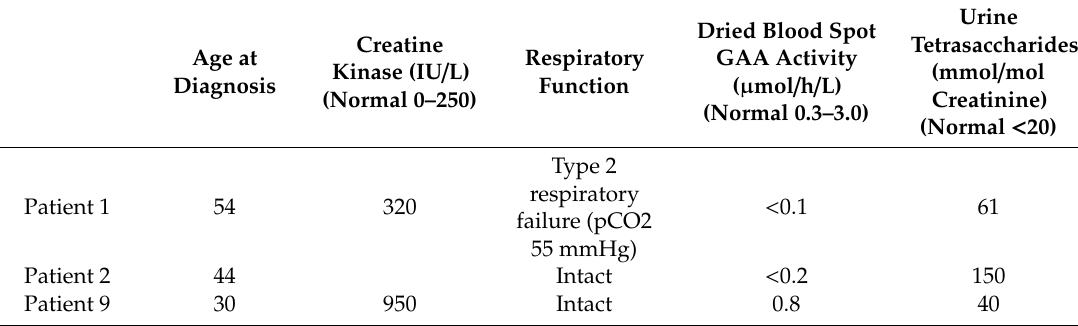
Table 2. Clinical assessments of